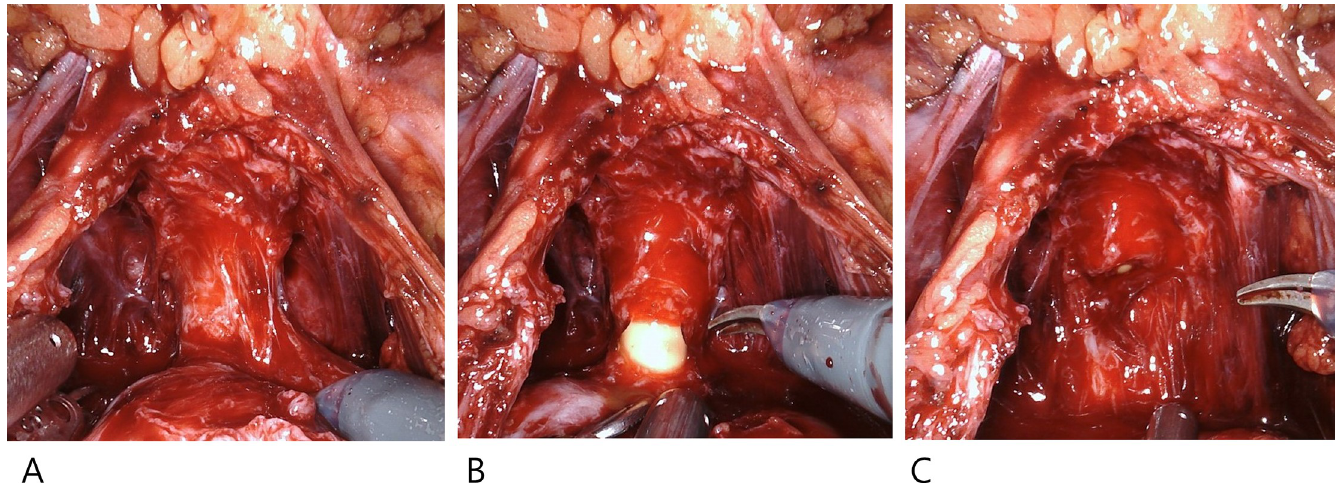
Fig 2. Preservation of maximal distal urethral length and pelvic floor tissue.